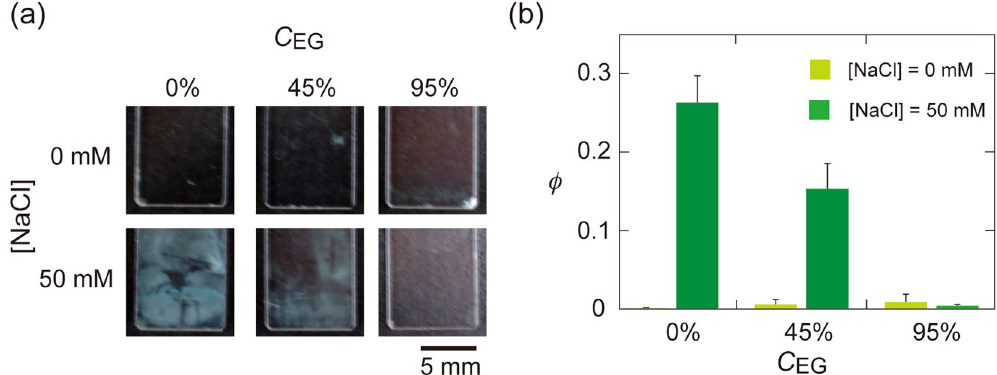
Figure 5. The influence of C EG on the adsorption of silica 1 particles on quartz plates at two values of [NaCl]. Overviews of ( a ) the adsorption states and ( b ) φ values. Error bars represent standard